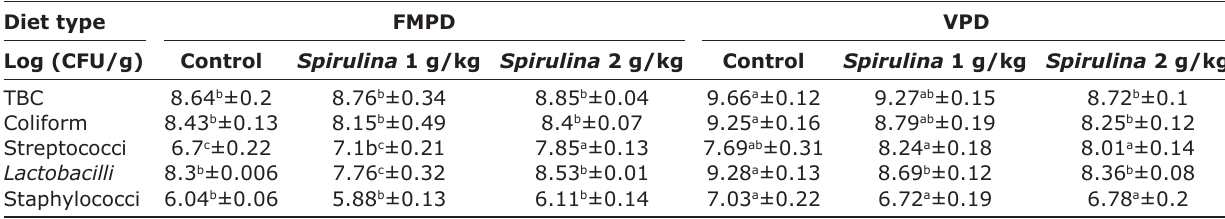
Table-5: Bacterial count in ileocecal content in different groups. Diet